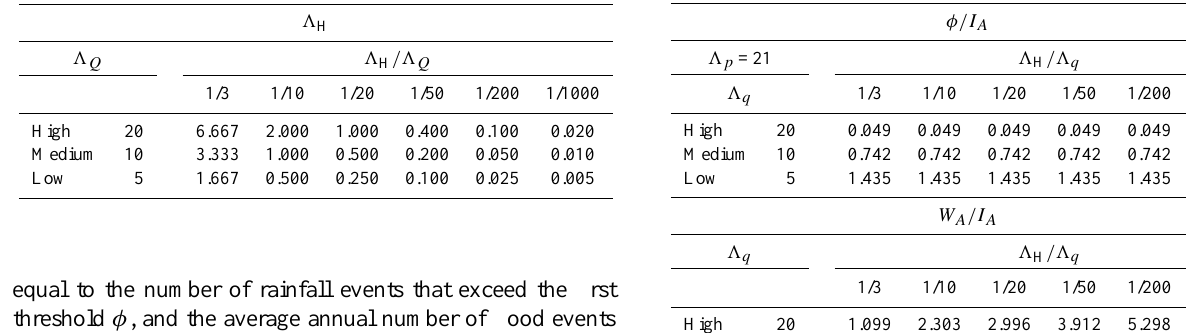
Table 3. Mean annual number of events of the 2nd component (H- type response) based on different values of 3 Q and 3 H /3 Q .